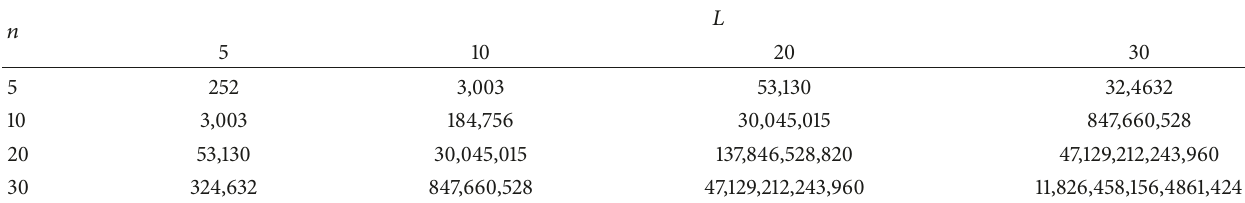
Table 1: Number of needed unknown terms in the polynomial